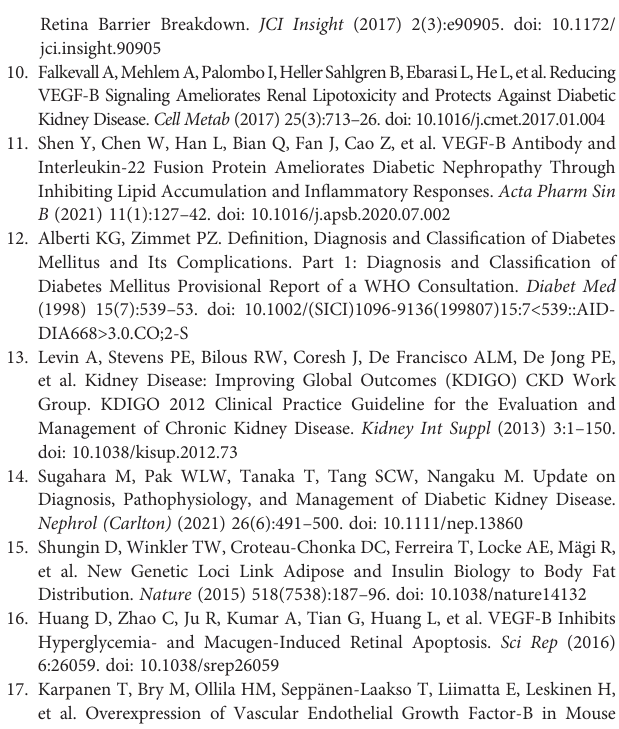
sample size. Current chronic kidney disease nomenclature